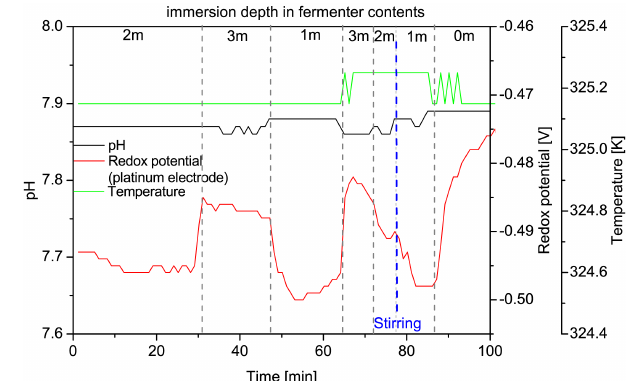
Figure 10. Course of the pH value, the redox potential and the tem- perature depending on the immersion depth of the measuring probe at test position 2 of the